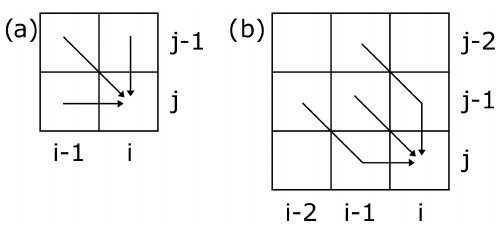
Figure 3. (a) Basic and (b) constrained stepping patterns for the DTW algorithm. Usage of cell [ i , j ] indicates that the i th element of the first and the j th element of the second data set were matched. The basic pattern allows for a single value to be assigned to arbi- trarily many values of the other data set, while for the constrained stepping, each value can only be identified with one or two others.